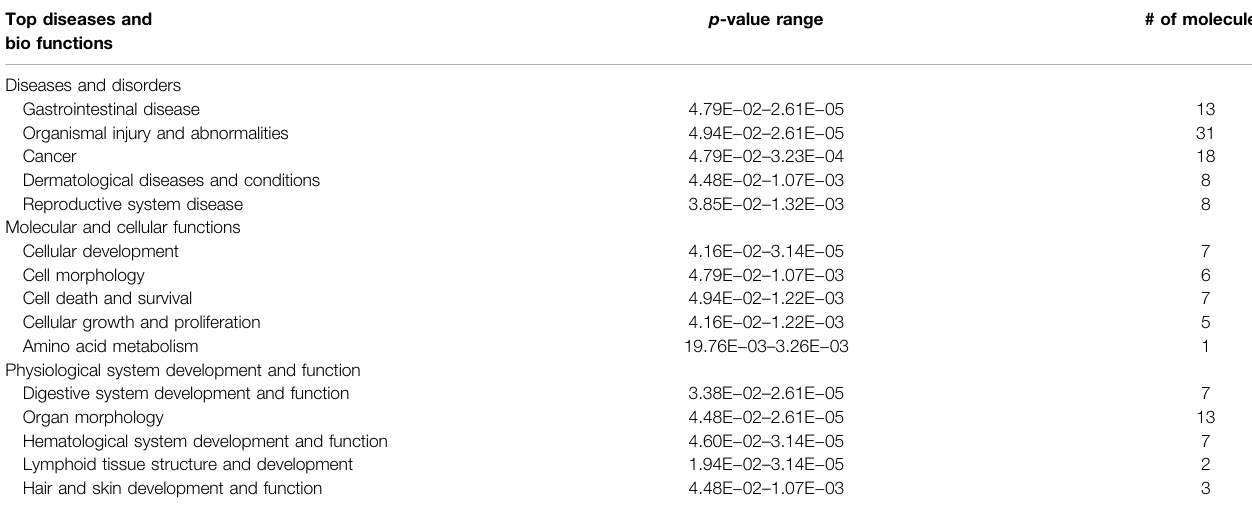
TABLE 1 | Functional analysis for the DEGs in the retina between Asrgl1 knockout mice and normal